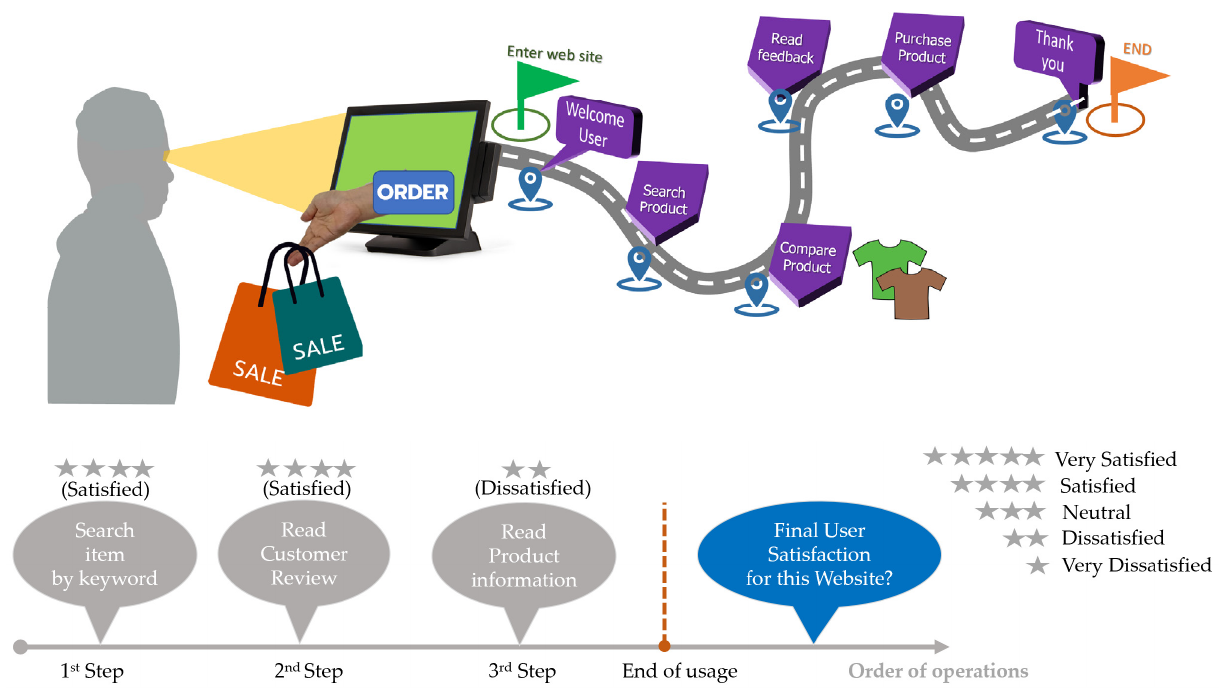
Figure 1 . User satisfaction while users are on a shopping website. Figure 1. User satisfaction while users are on a shopping